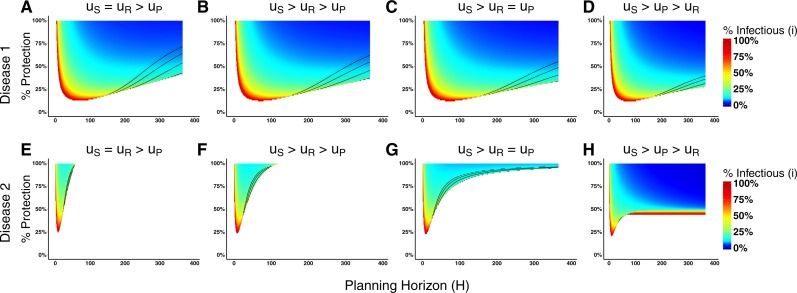
Heat maps of switching points under qualitatively different payoff relationships for Disease 1 and Disease 2.The heat maps in (A)–(D) correspond to Disease 1 and the heat maps in (E)–(H) correspond to Disease 2. In (A) and (E) the payoff of being susceptible and recovered are equal, which means that agents recover completely from the disease after infection. In (B) and (F), the recovered payoff is lower than the susceptible payoff, but still greater than the prophylactic payoff meaning that being recovered is preferable to than being in the prophylactic state. In (C) and (G), the payoff for the prophylactic and recovered states are exactly equal. In (D) and (G), the disease is permanently debilitating such that the payoff of the recovered state is less than the prophylactic state. The heat maps of behavioral change assume the following payoffs for uS, uP, uI, uR. (A):{1, 0.95, 0.1, 1}, (B):{1, 0.95, 0.1, 0.97}, (C):{1, 0.95, 0.1, 0.95}, (D):{1, 0.95, 0.1, 0.9}, (E):{1, 0.95, 0.6, 1}, (F):{1, 0.95, 0.6, 0.97}, (G):{1, 0.95, 0.1, 0.95}, and (H):{1, 0.95, 0.1, 0.9}. The % Protection corresponds to the percentage of protection obtained for adopting prophylactic behavior, (1 − ρ) × 100.